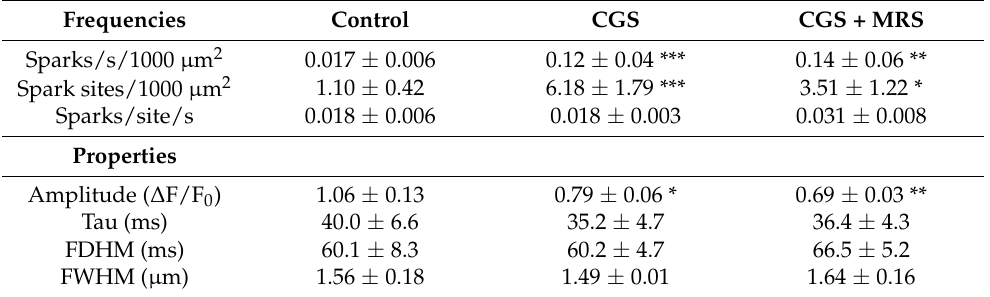
Table 2. Impact of the treatment with 200 nM CGS21680 (CGS) and 1 µ M MRS1191 (MRS) on the incidence of calcium sparks and their properties in human atrial myocytes. Significant differences between treatment and control are indicated with * p < 0.05, ** p < 0.01, *** p <